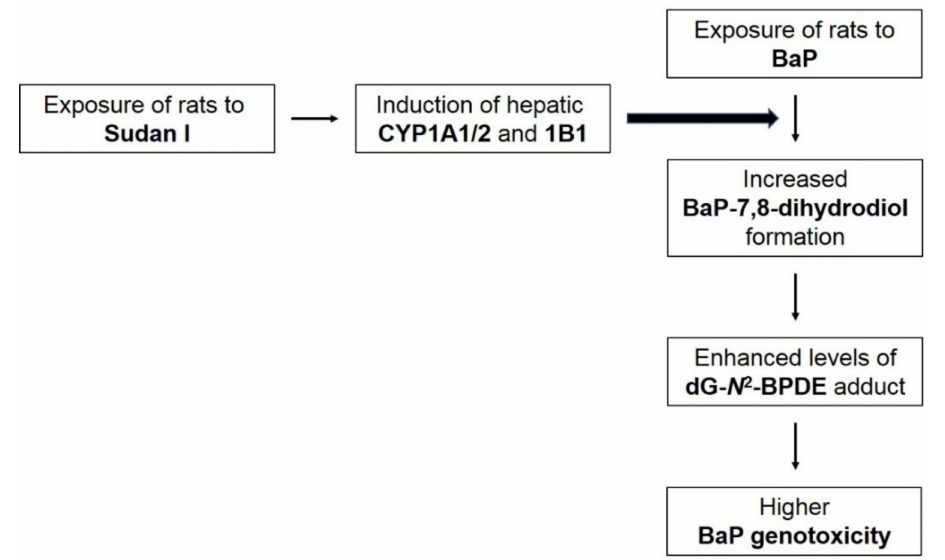
Figure 9. Proposed scheme of Sudan I impact on increased BaP-induced genotoxicity in rats exposed to Sudan I before